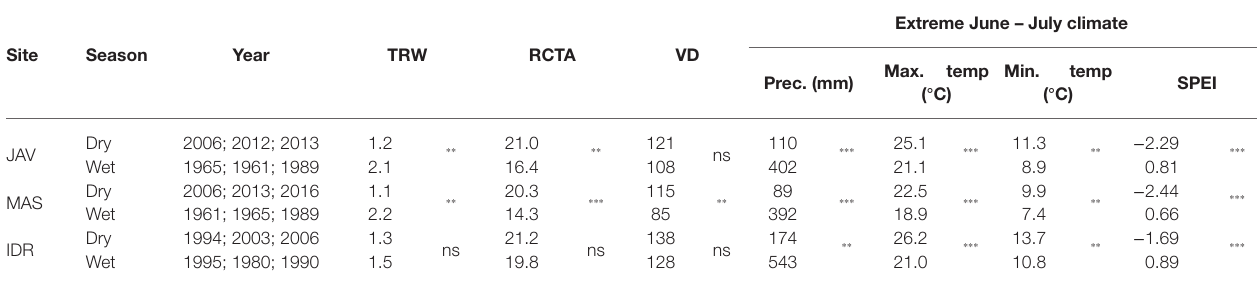
TABLE 3 | Differences in mean tree-ring parameters and mean summer climatic conditions among the three wettest and driest years at sites Javornik (JAV), Mašun (MAS), and Idrija (IDR).